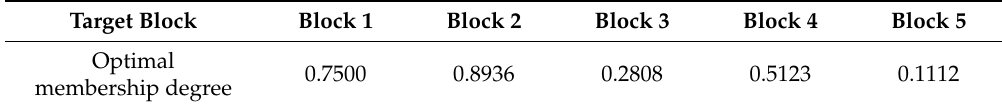
Table 5. Results of gray correlation evaluation of CBM